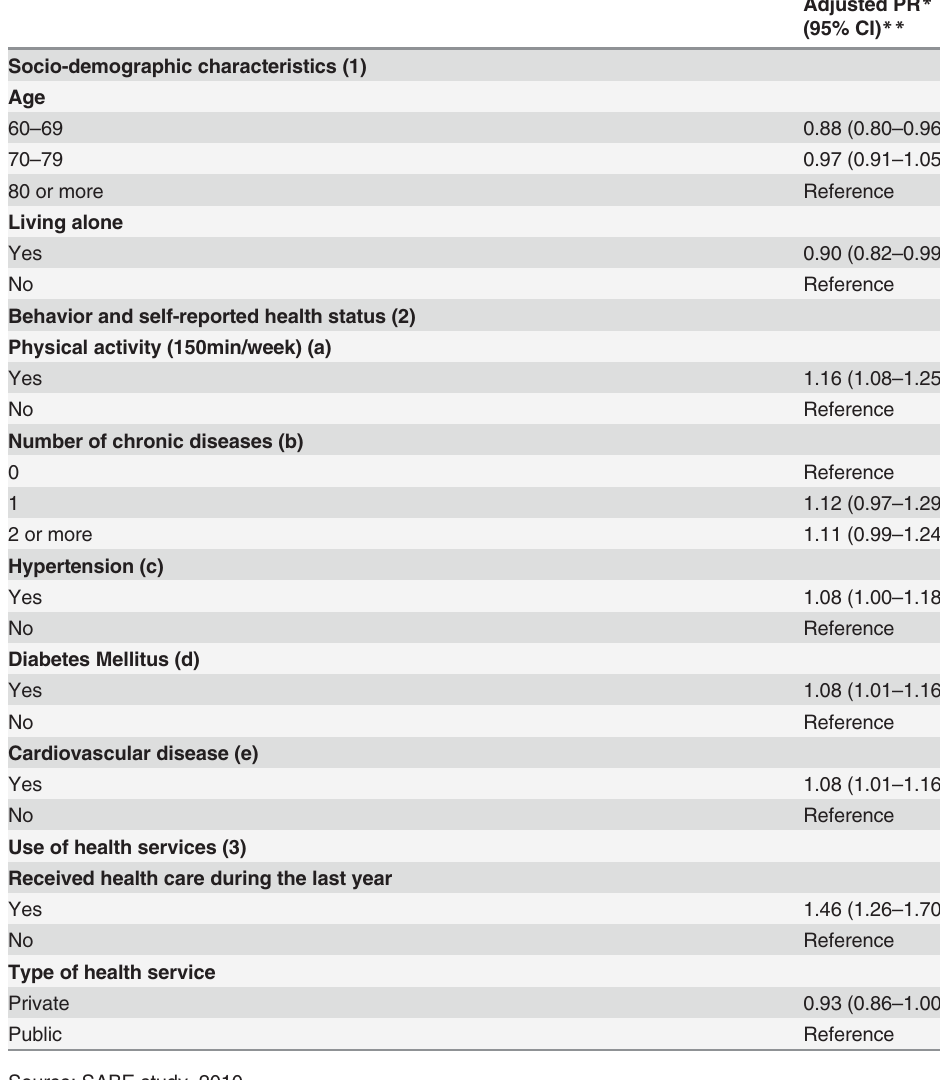
Table 5. Multiple variables analysis: Poisson regression model for influenza vaccination among the elderly (n = 1,341). S ã o Paulo, Brazil,